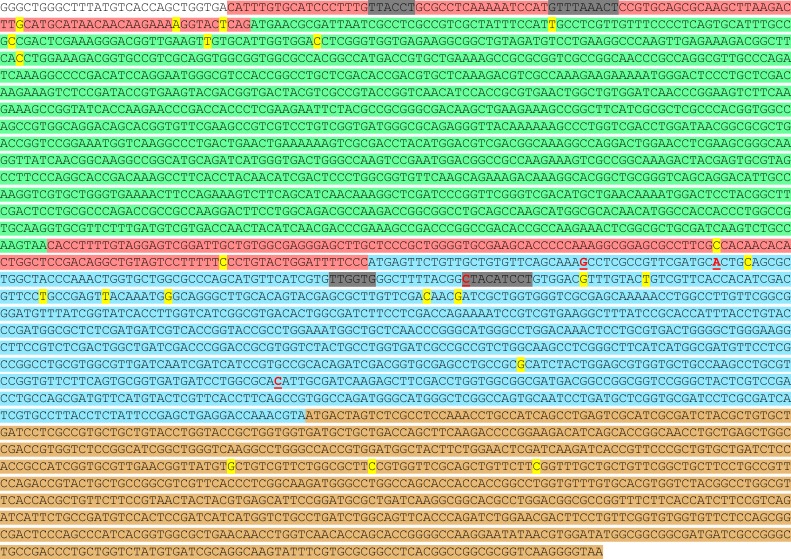
Locations of potential transcriptional start sites in the gts operon.The precise nucleotide positions of the 5’ ends are highlighted yellow within the intergenic (pink) and coding sequences of gtsA (green), gtsB (blue), and gtsC (brown). Positions of gtsB mutations (A10T, A15A, G38G, and 232–3T) are in red text and underlined. Predicted promoter sites using Softberry’s BPROM prediction software are highlighted grey.